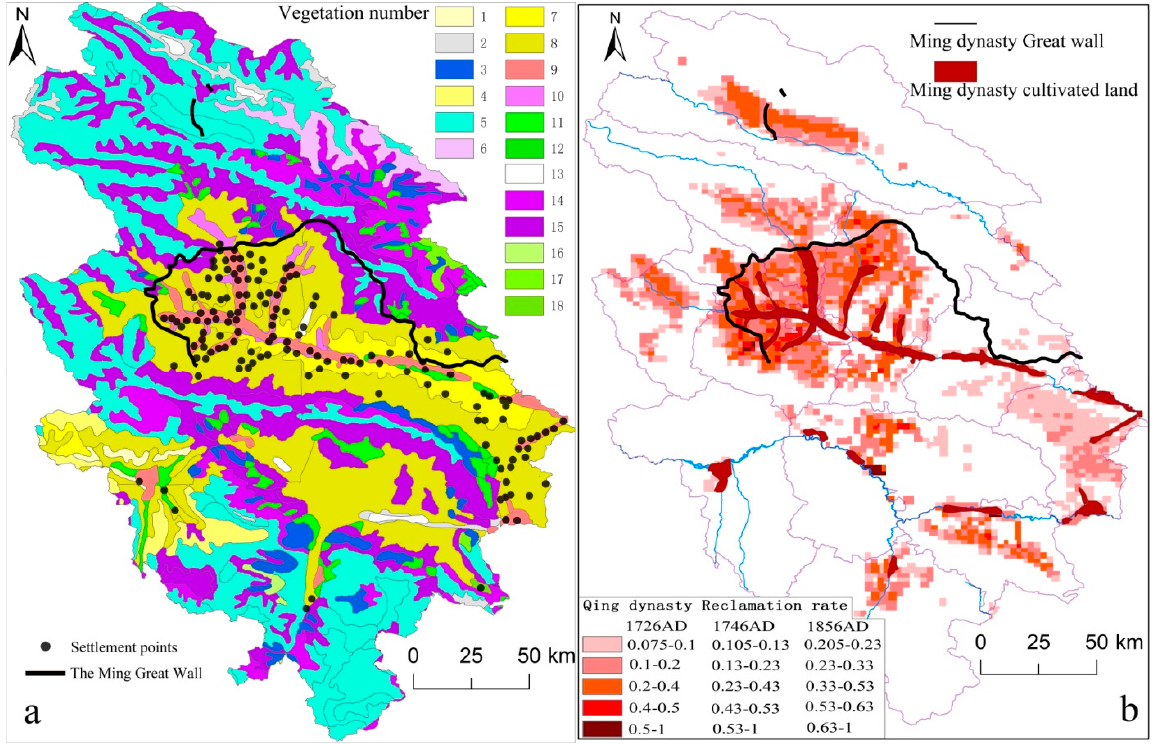
Figure 3. ( a ) Distribution of cropland–vegetation in 1640AD;( b ) Distribution of cropland in the Qing Dynastyin the Hehuang valley.The vegetation type coded in Figure ( a ) is the same as Table 3 and 9 is the cropland distribution area; In Figure ( b ), the distribution data of reclamation rate in 1726AD, 1746AD, and 1856AD were obtained through the literature collation [23].